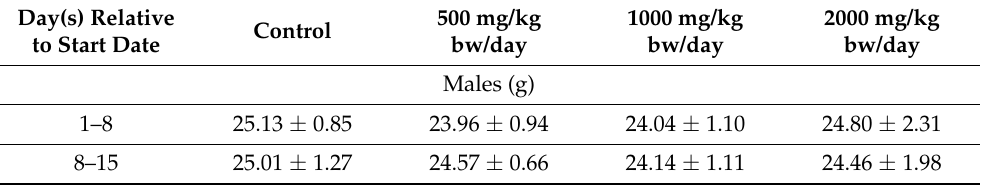
Table 3. Mean daily food consumption for the 28-day repeat dose oral toxicity study with